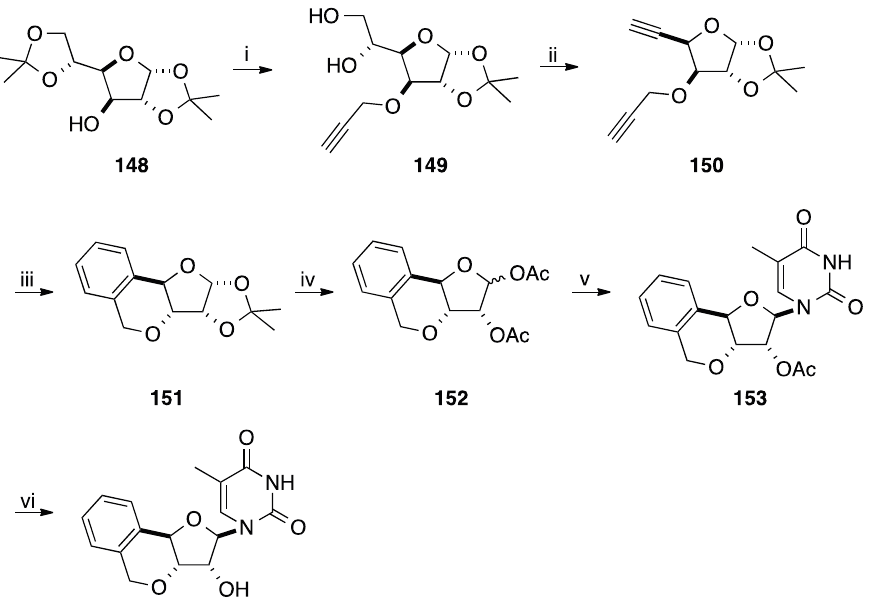
Scheme 19. Synthesis of isochroman derivative 154 .